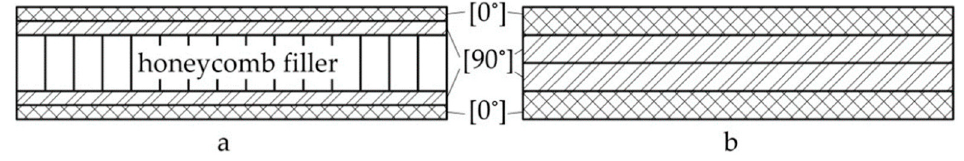
Figure 3. Layup pattern for sandwich panel ( a ) and laminated panel ( b ).